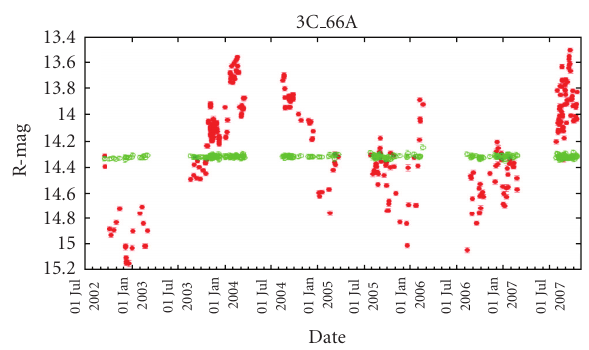
Figure 8: IBIS gamma-ray light curve of 1ES 1959+650. Blazar is in INTEGRAL gamma-ray imager IBIS visible only in data set corresponding to optical flare.